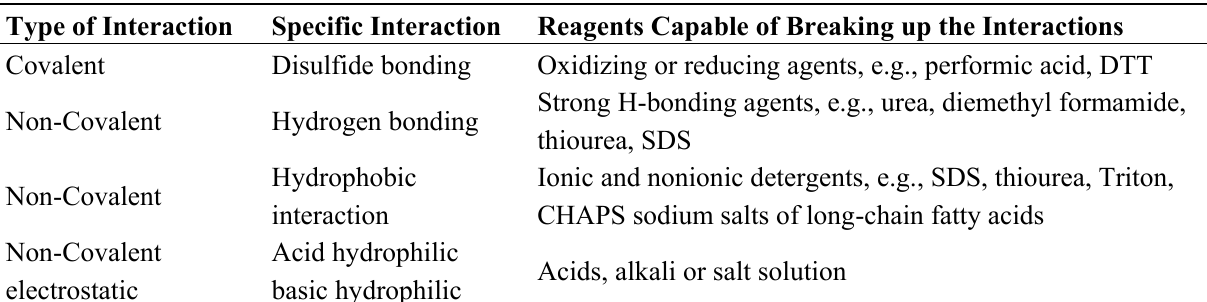
Table 4. Types of interactions, specific interactions and reagents able to break up the interactions [142].